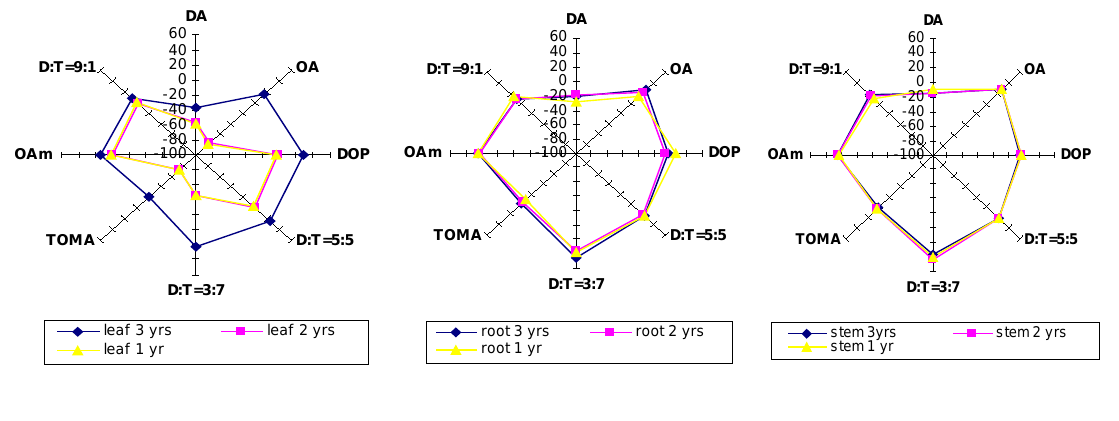
Figure 4. Typical potentiometric fingerprint profile of E. longifolia leaf, root and stem during different stage of maturity at one, two and three years of cultivation.